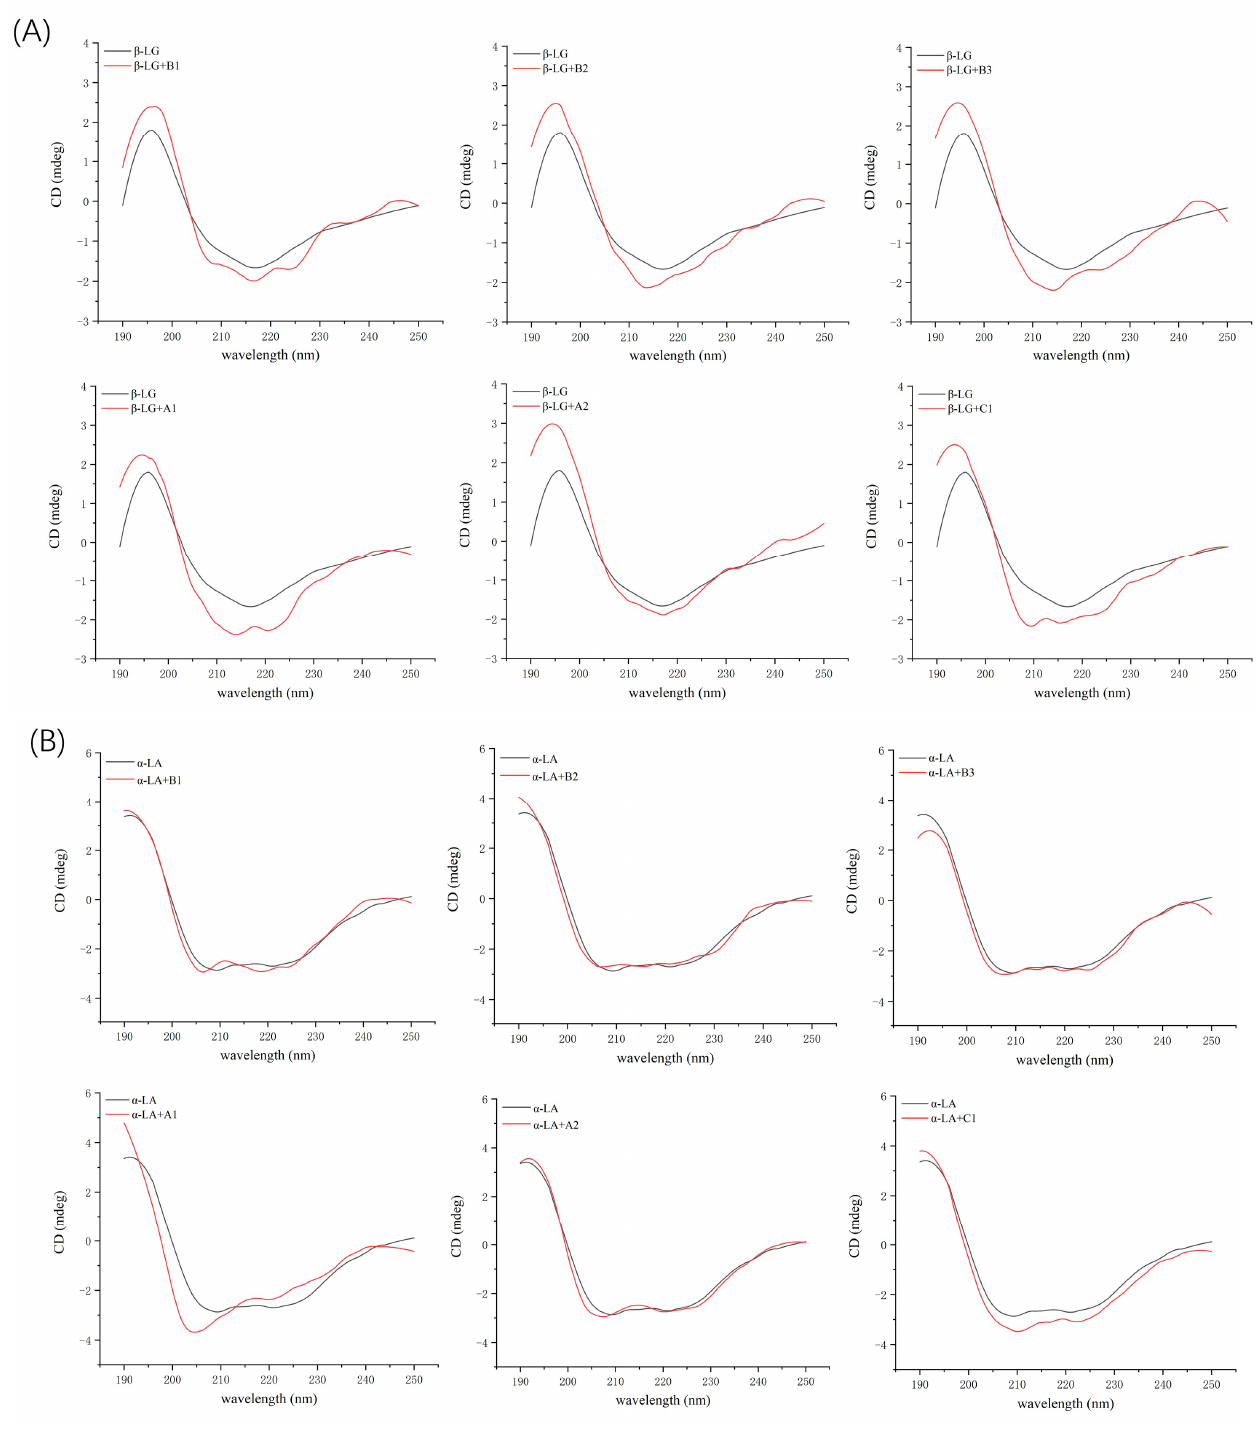
Figure 6. Far ultraviolet CD spectra of β -LG ( A ) or α -LA ( B ) (10 µ M) with proanthocyanidin A1, A2, B1, B2, B3, and C1 (50 µ